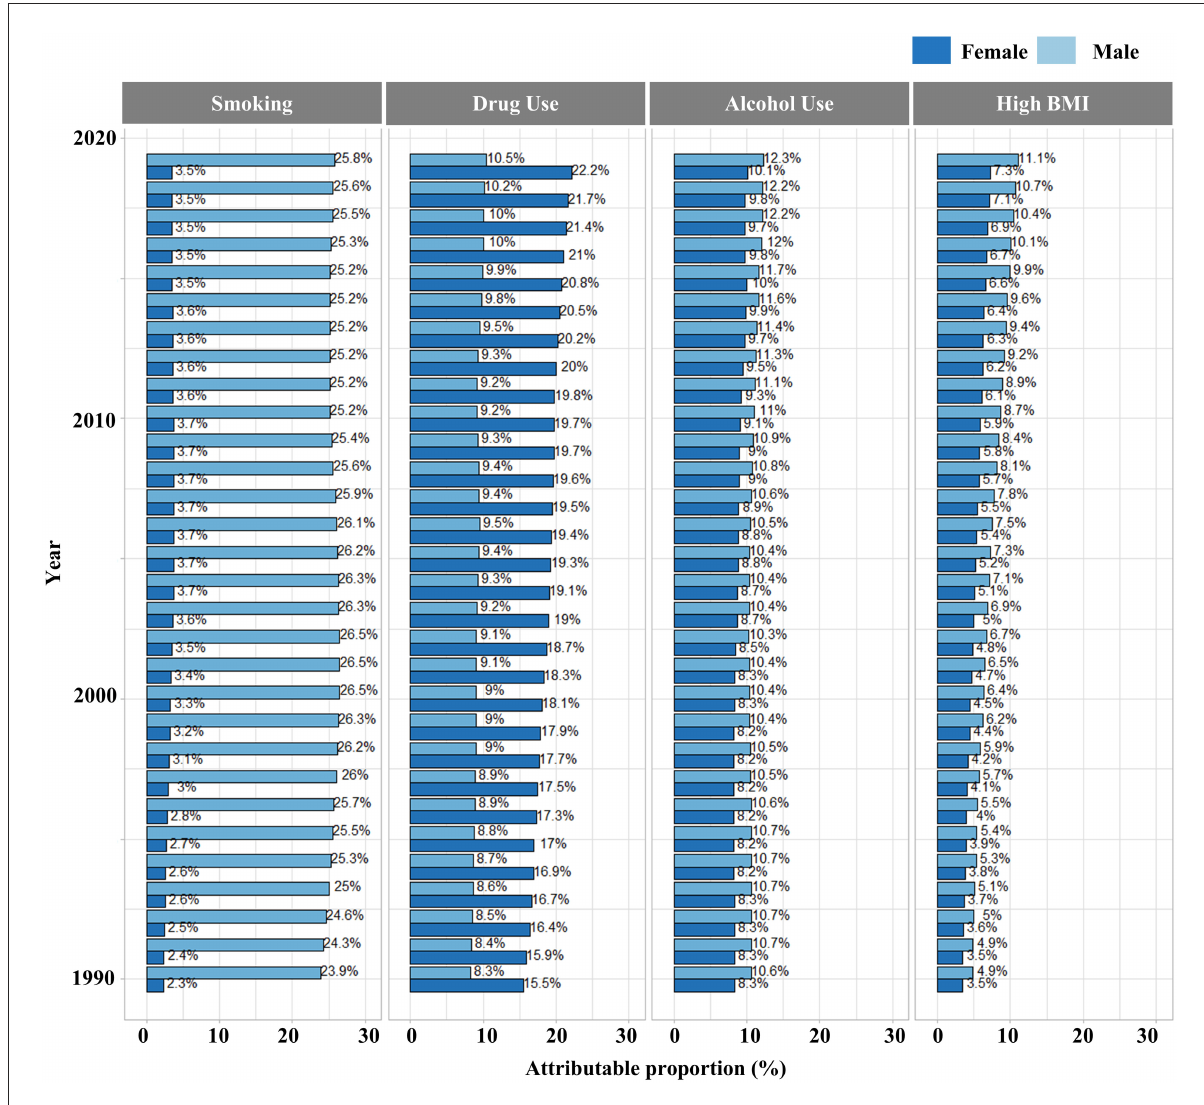
FIGURE3 Proportions of LC-associated deaths attributable to four risk factors (alcohol use, drug use, high BMI, smoking) from 1990 to 2019.